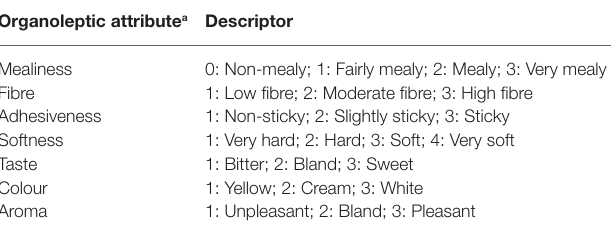
TABLE 1 | Scales used in sensory analysis of boiled cassava